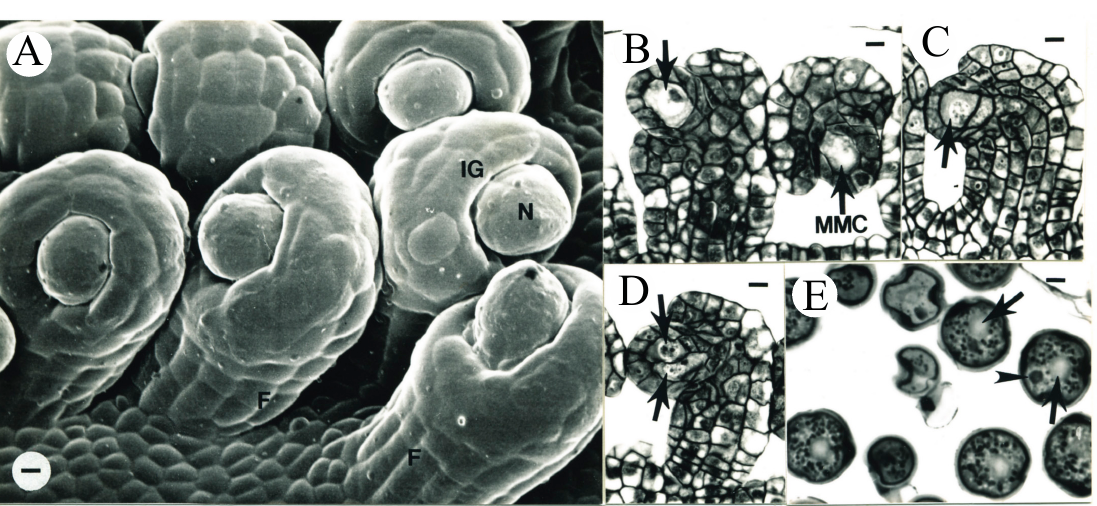
Figure 9. Tobacco ovule development during the 15th day after ECP ( A – D ) and anther development during the 16th day after ECP ( E ). ( A ) SEM micrograph of representative ovules from the age interval 14.4 ± 1.3 days after ECP. The integument (IG) surrounds the nucellus. The funiculus (F) has di ff erentiated. Bar = 6.7 µ m. ( B – D ) Longitudinal sections of ovules similar to those shown in ( A ). ( B ) Megasporocytes in meiosis (arrowhead). Bar = 10.3 µ m. ( C ) Two megasporocytes observed in one ovule. The smaller one is behind the larger one (arrow). Bar = 10.3 µ m. ( D ) Two megasporocytes observed in one ovule (arrows). Bar = 10.3 µ m. ( E ) Evident pollen grains each containing a vegetative cell (arrowhead) and a generative cell (arrows) with the average flower age of 16.0 ± 0.4 days after ECP. Bar = 6.1 µm.